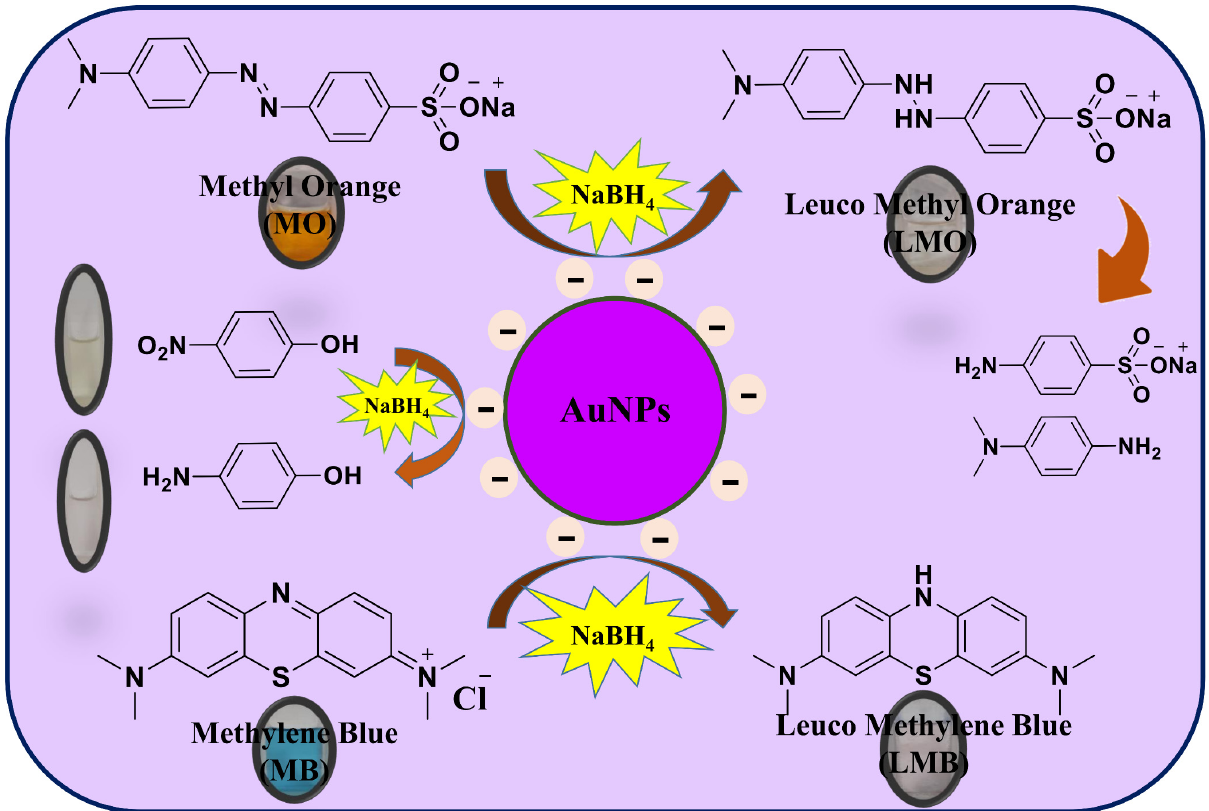
Figure 13. The mechanism of action of catalytic degradation of three dyes (MB, MO, and 4-NP) using biofabricated CC-AuNPs and NaBH 4 under visible light.